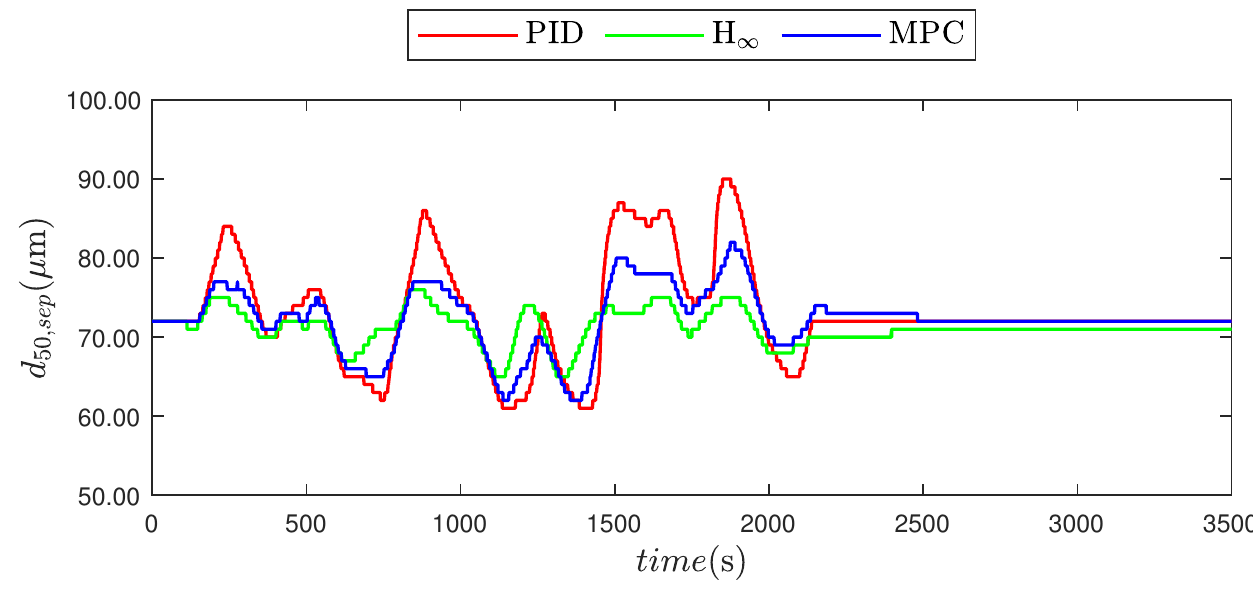
Figure 21. d 50 in separator water-phase outlet/hydrocyclone inlet.